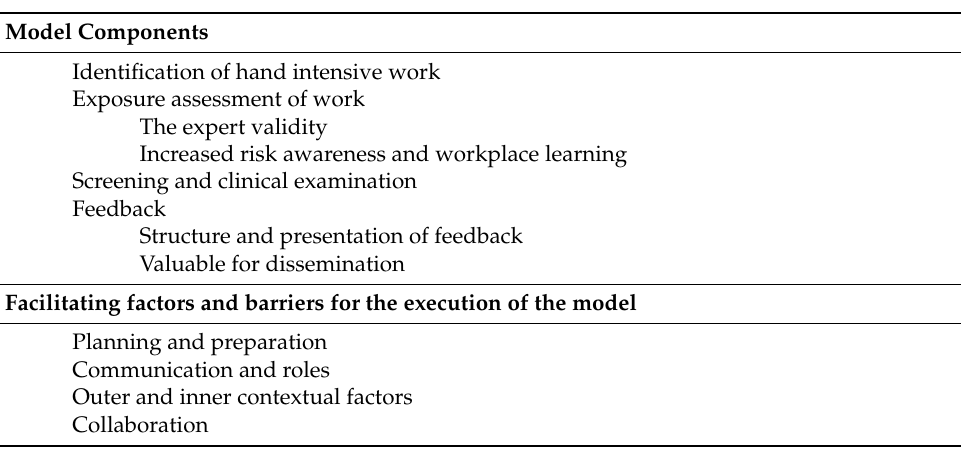
Table 2. Categories and sub-categories responding to the questions about experiences of the model components and facilitating factors for the